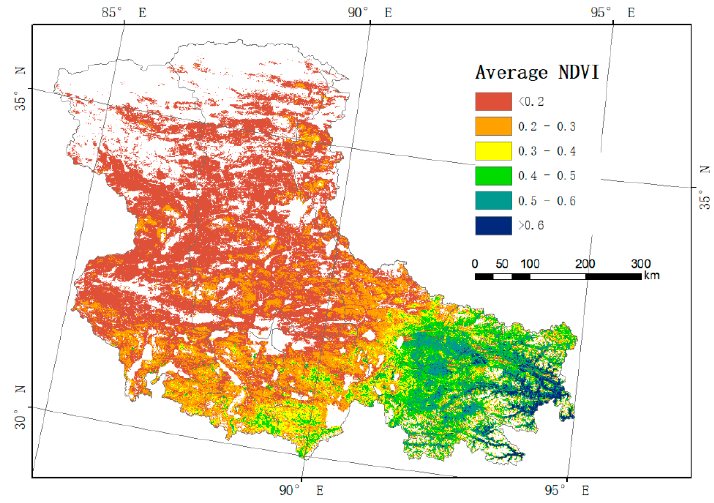
Figure 3. The spatial distribution of average NDVI in growing season in northern Tibet.